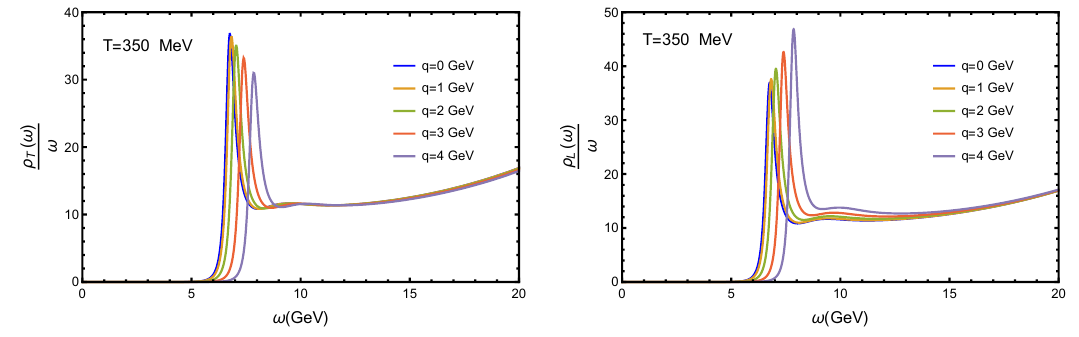
Figure 4 . Spectral Function for bottomonium with di(cid:11)erent values of linear momentum at (cid:12)xed value of